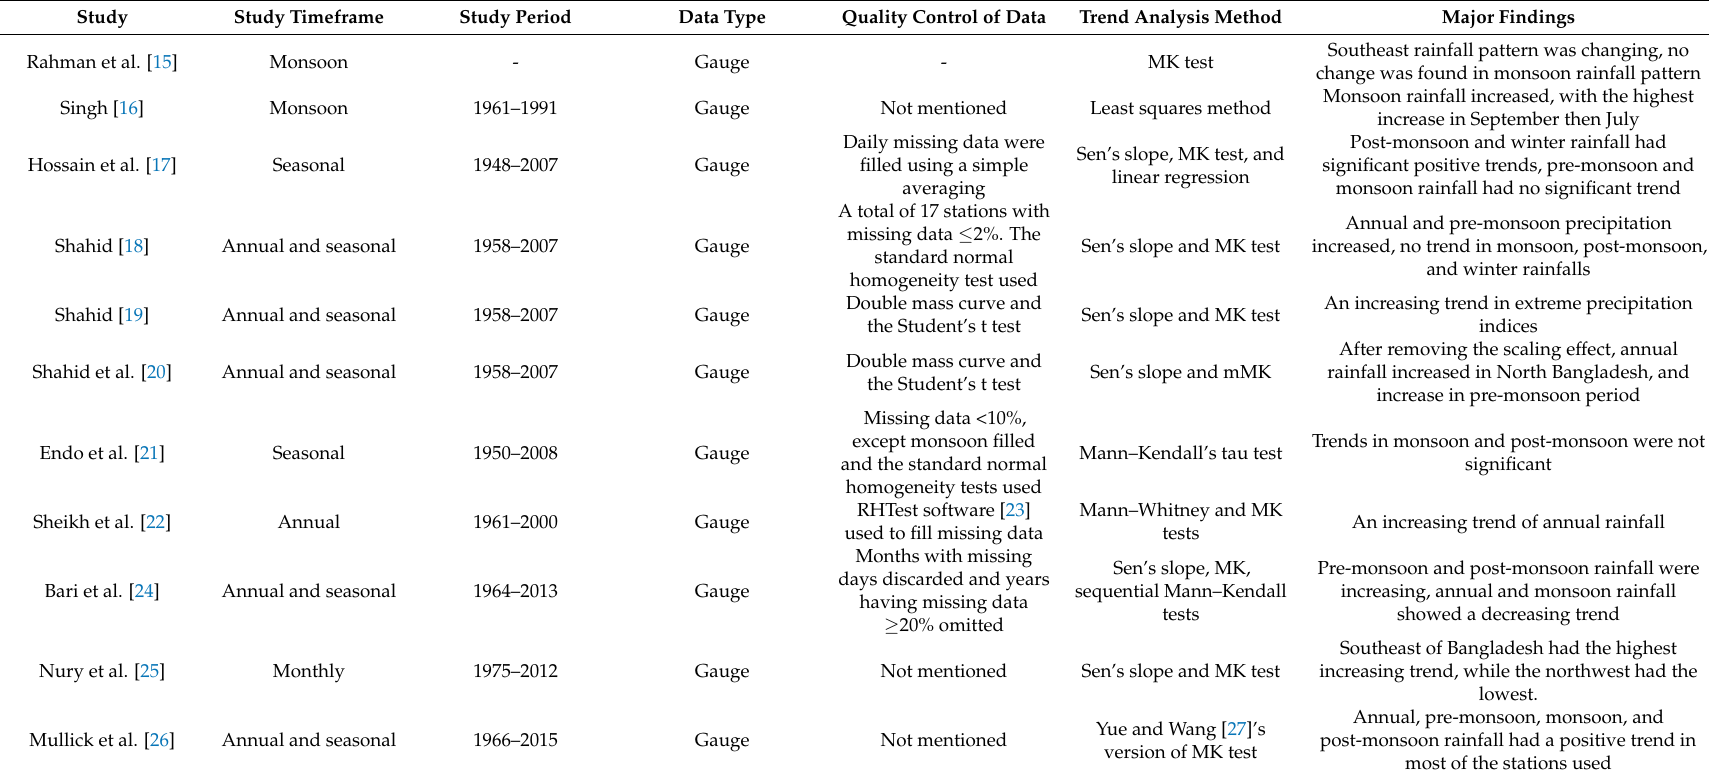
Table 1. Summary of recent studies on rainfall trend in